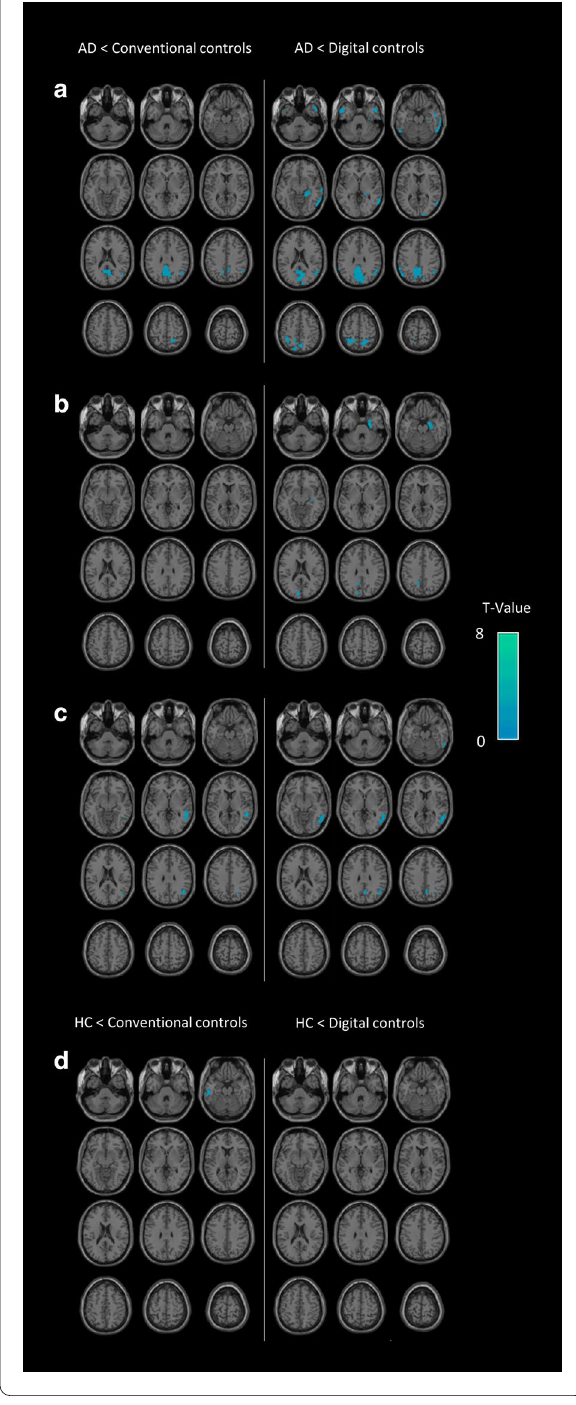
Fig. 5 Galleria of individual examples with both semi‑quantitative analyses to conventional and digital controls. Three examples of SPM‑T map images from semi‑quantitative analyses to conventional (left panel) and digital (right panel) controls of patients with AD ( a